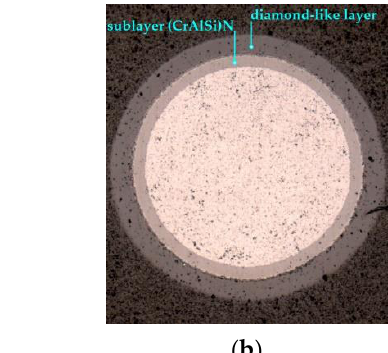
Figure 10. Measurements of the end mill roughness before ( a ) and after the etching ( b ).